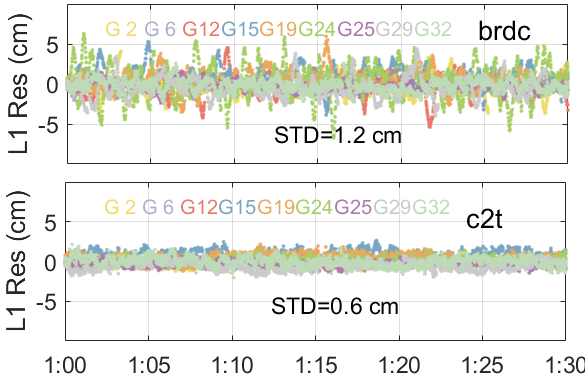
Figure 5. Illustration of L1 carrier residuals for GPS ARTK using broadcast and c2t-5s ephemeris.